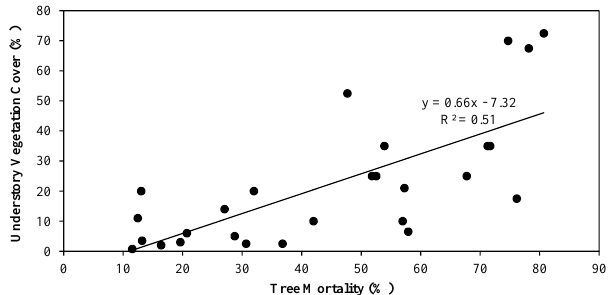
Fig. 6. Understory vegetation cover as a function of post-outbreak percent tree mortality, within gray-attack-dominated (4–13yr since outbreak start) field tree